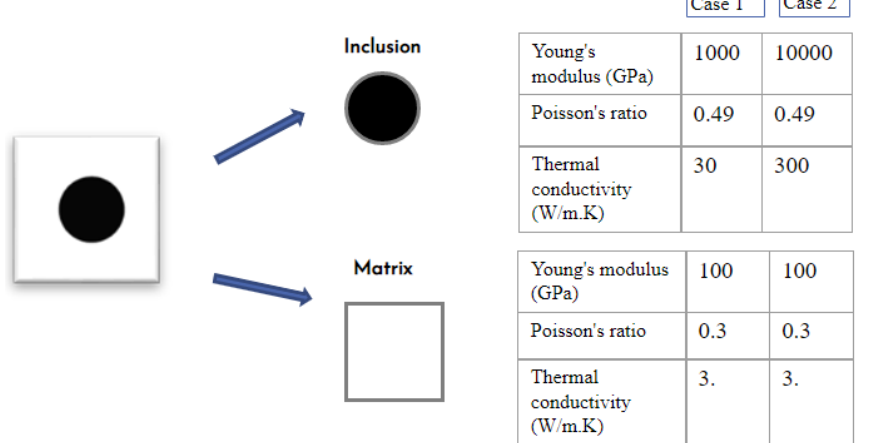
Figure 3. The elastic (Young modulus) and thermal (Thermal conductivity) properties of two different material phases (the values in the table are not realistic, just used for the calculation).